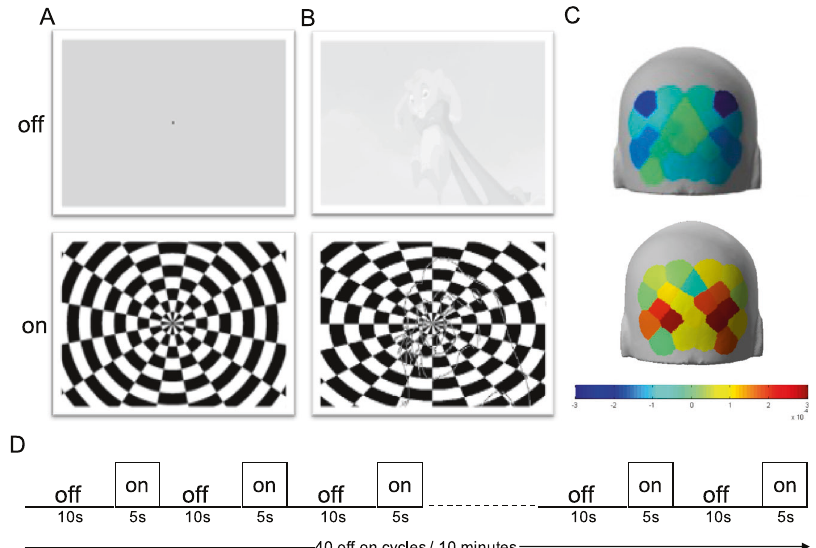
Fig. 1 Visual stimulation and experimental paradigm. A Representative frame of baseline grey screen (upper row, stimulus ‘ off ’ ) and reversing checkerboard (lower row, stimulus ‘ on ’ ) for RS condition. The small black square indicates the fi xation point. B Representative frame of low-contrast (20%) grey-scale baseline animated cartoon (upper row, stimulus ‘ off ’ ) and blended checkerboard-cartoon (lower row, stimulus ‘ on ’ ) for Cartoon-Fixed (CF) and Cartoon Chosen (CC) conditions. C Representative HDR in the occipital cortex during the stimulus ‘ off ’ (upper row) and stimulus ‘ on ’ activation phase (lower row) according to the output of nirsLAB software. The Look Up table is reported under the images. D Experimental protocol showing that the cycles of visual stimulation were structured in blocks of 40 trials (20 trials with the reversing checkerboard and 20 trials with the ‘ mock ’ stimulus) for a total duration of 10